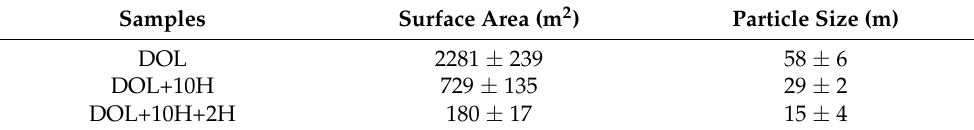
Figure 1. SEM images of filler particles of ( a ) DOL, ( b ) DOL+10H and ( c ) DOL+10H+2H at 500 × magnification ( left ) and 1000 × magnification ( right ). Table 2. Surface area and particle size of (DOL), (DOL+10H) and